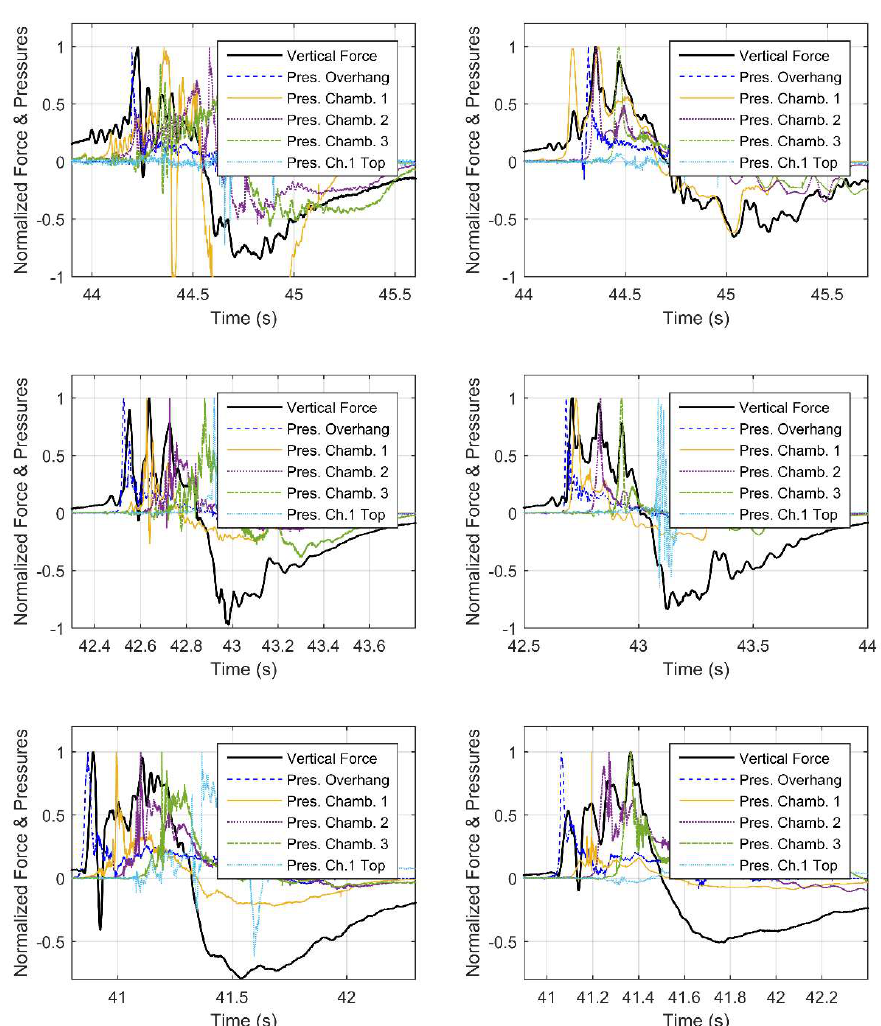
Figure 11. Time histories of normalized vertical forces and pressures below the deck for a deck with cross-frames ( left ) and with solid diaphragms ( right ) for two solitary waves, with H = 0.42 m ( top ), H = 0.65 m ( center ), and a bore with H = 0.92 m ( bottom ).